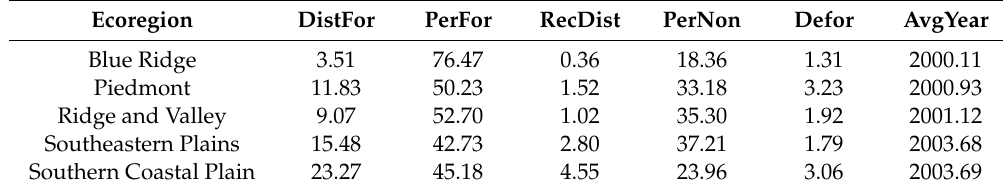
Figure 4. Disturbance pattern classification maps by county. ( a ) Mean last disturbance year for the disturbed pixels ( b ) Ratio of the disturbance after 2011 to all of the disturbances detected between 1987–2016. Table 3. Land-use pattern classification in Georgia.